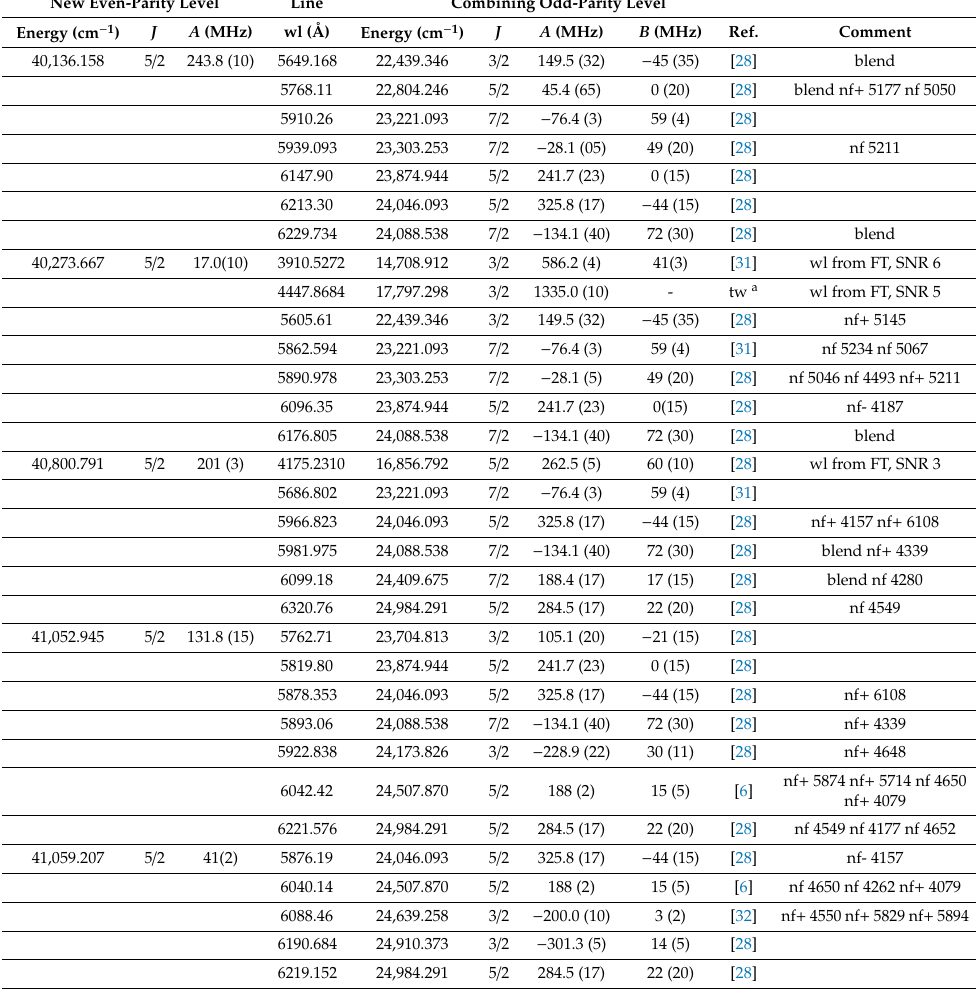
Table 2. Properties of the new even-parity levels and classified lines. Uncertainty of the energies of the “Ref.” the source of the hf constants A and B of the combining levels is given. The value of B could not be determined for the new levels and was assumed to be zero. Uncertainties of A -values determined in this work to